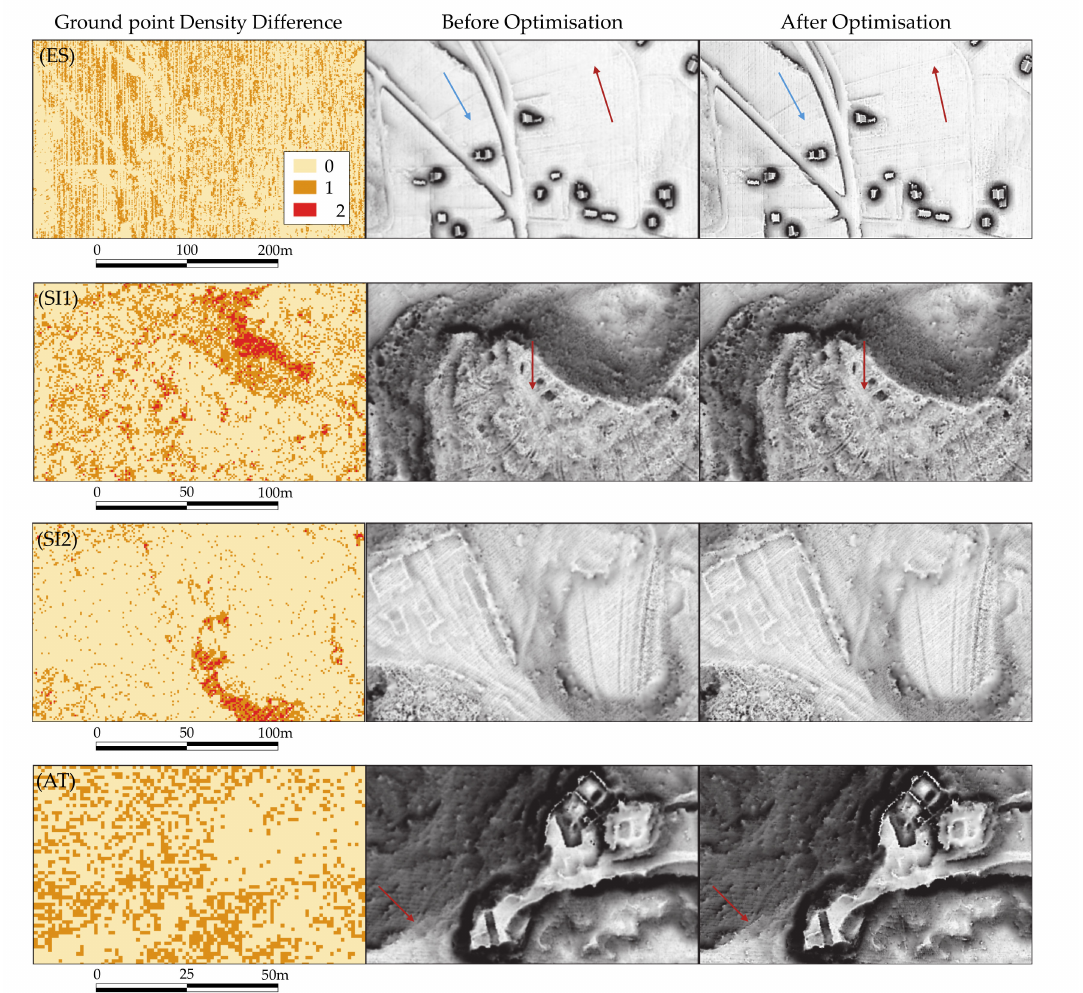
Figure 15. Benefits of non-last-return ground point classification. Ground point density difference is a measure of ground points gained per grid cell. Arrows point to observable differences potentially relevant to archaeology before and after optimization. Processing other than ground point optimization: see Table